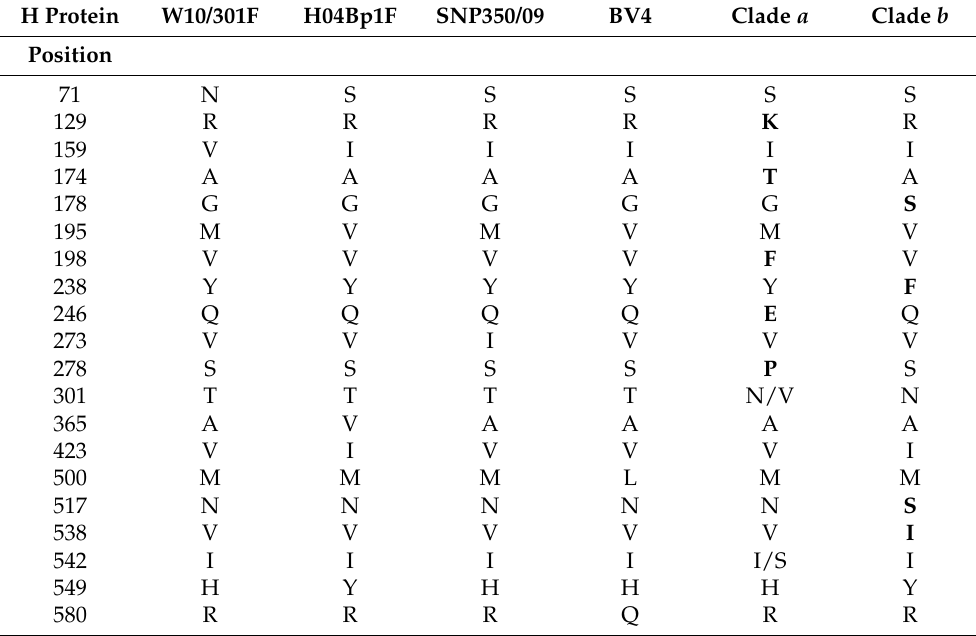
Figure 4. Distribution of clade a and b from Valchiavenna and High Valtellina, respectively. A molecular analysis of the deduced sequence of the protein H of the nine Italian CDV strains showed 98.2 to 98.8% identities with the W10/301F strain of the EU1 lineage. Of these, five sequences belonged to clade a and were highly homologous to each other (from 99% to 100% identity). The other four sequences, belonging to clade b , showed an identity of 99.7% to 99.8%. The amino acid substitutions observed in the consensus sequences of the Italian clades a and b were compared with the residues present in the homologous protein sequences of the most closely related strains of the EU1 lineage. Several amino acid substitutions were unique to the Italian strains and determined the two clades (Table 3). Table 3. Amino acid substitutions across the consensus sequences of the Italian clades a and b and their closely related strains of the EU1 lineage. Amino acid mutations defining clades a and b are identified in bold (H: